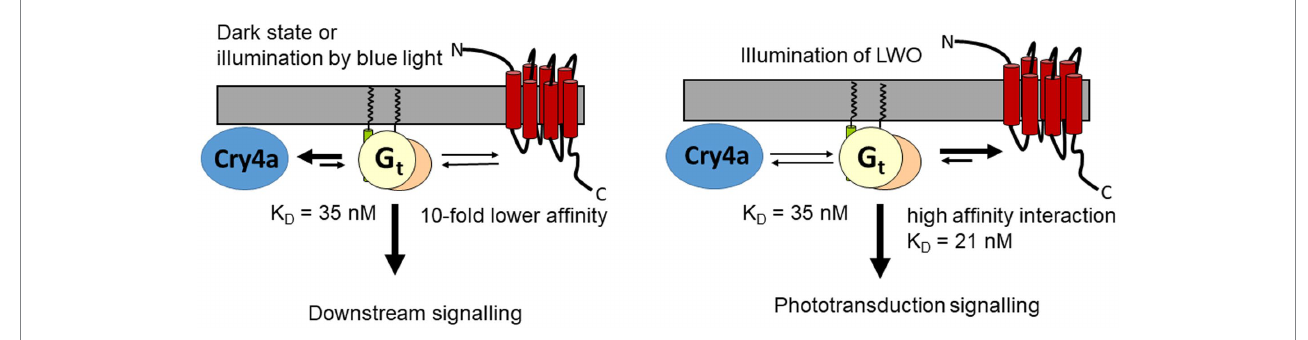
FIGURE 6 Hypothetical interaction scheme showing two scenarios, interaction of Gt with Cry4a, when LWO is not illuminated, and Gt interacting with LWO under illumination of LWO. The K D value of 35 nM is taken from Görtemaker et al. (2022), K D = 21 refers to the present